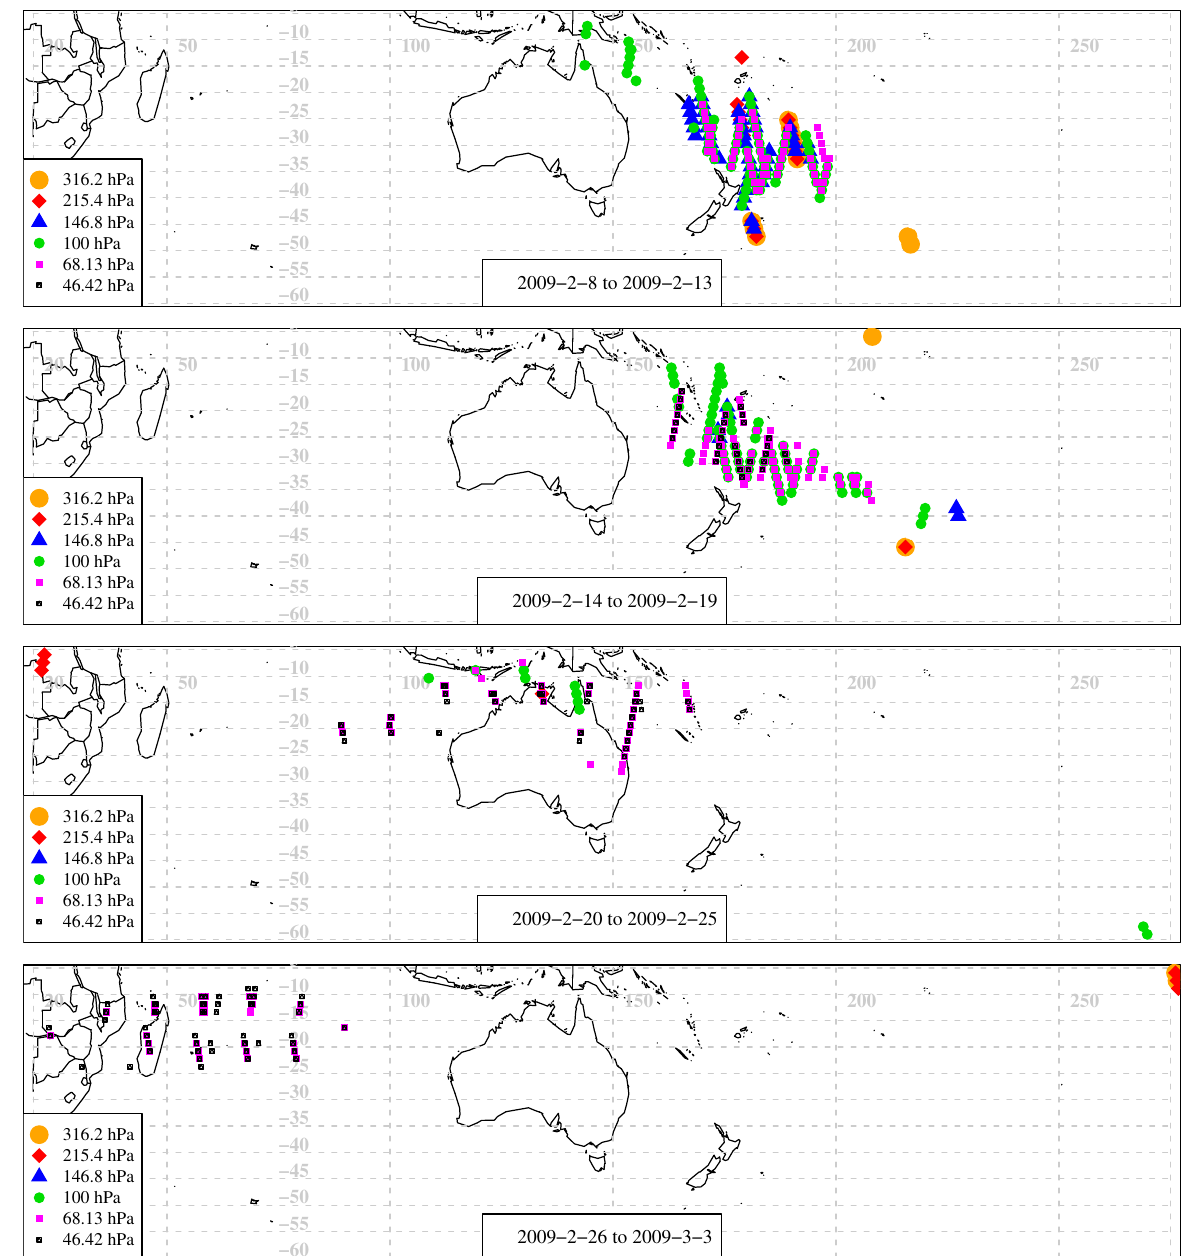
Fig. 2. Locations of MLS measurements where the CO values are anomalously high as defined in the text. The four maps show four successive 6-day periods beginning on 8 February, one day after the Black Saturday fire. (Dates are shown at the bottom of each panel in the form Year-month-day.) Apart from a few instances at the higher pressures, these points all appear to be part of the same